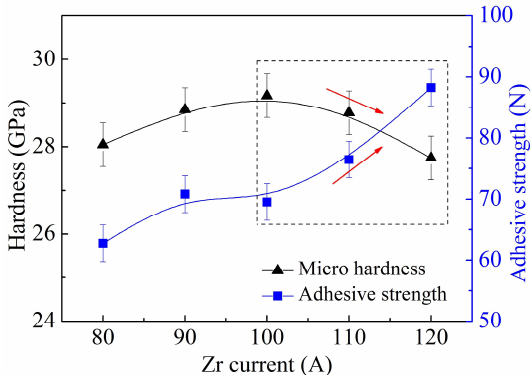
Figure 1. The hardness and adhesive strength of the coatings varied with Zr current [23].